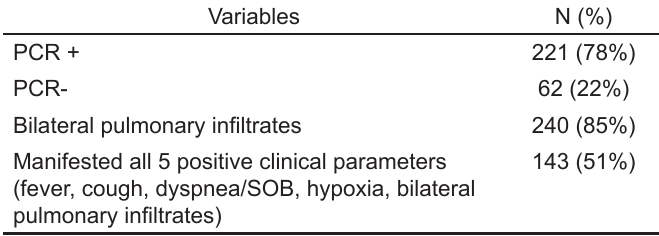
Table 2. Clinical characteristics of 283 suspected cases of COVID-19 admitted to the hospital.